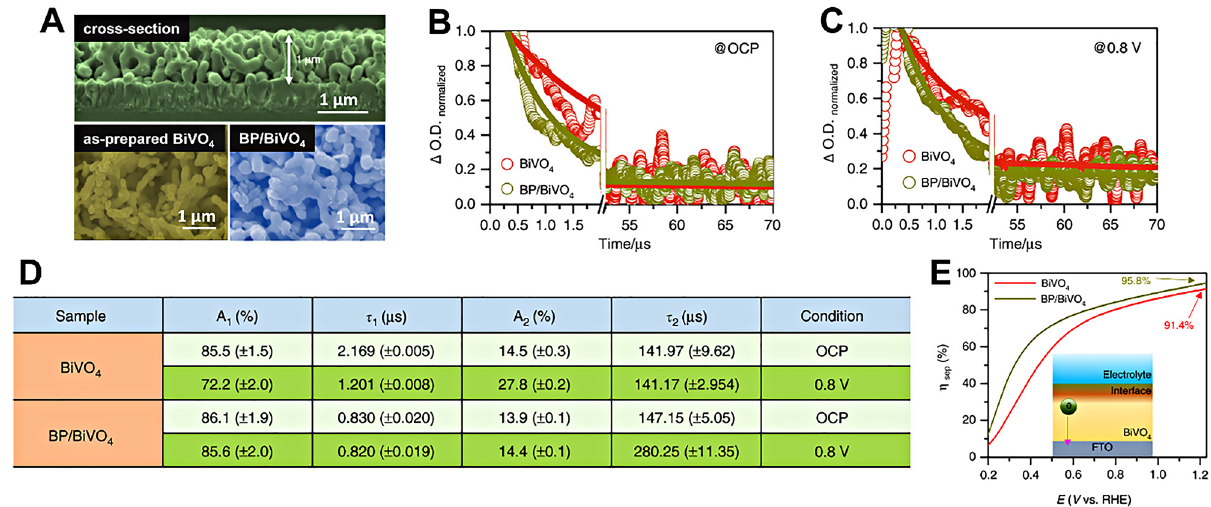
Figure 4: (A) SEM images of BiVO 4 and black phosphorene (BP)/BiVO 4 . (B – C) In situ TA pro fi les of the photoholes (500 nm) for BiVO 4 and BP/ BiVO 4 at OCP (B panel) and 0.8 V (C panel) in 0.5 M KPi. (D) Fitting parameters of the recorded TA pro fi les. (E) η sep of BiVO 4 and BP/BiVO 4 at different applied biases. Reprinted with permission from a study by Zhang et al. [42]. Copyright 2019 Springer